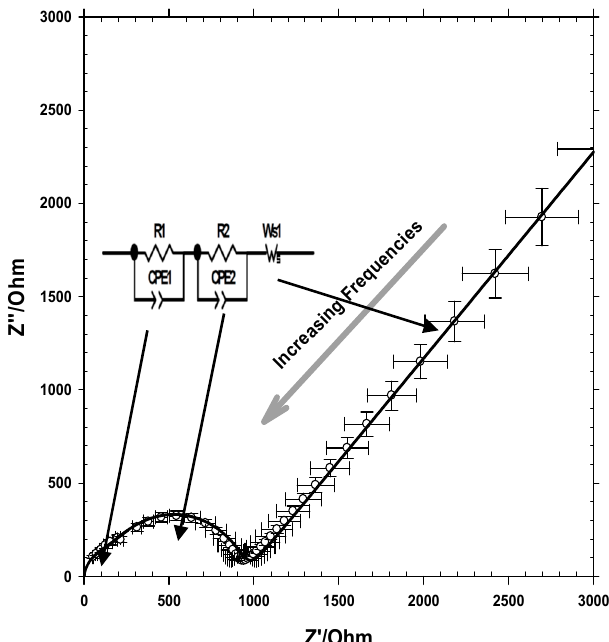
Figure 6. Nyquist plot for the HFM183 membrane and a concentration of 0.005 mol · L − 1 of K 2 CrO 4 . Experimental points with error crosses and the best fitted curve are shown.